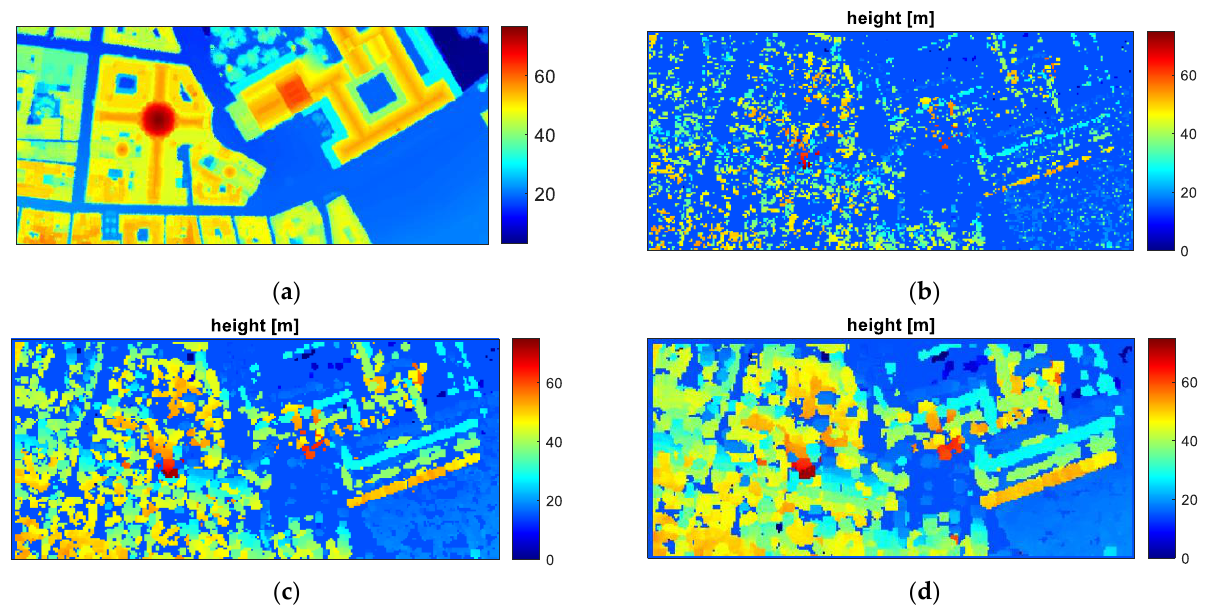
Figure 3. Images of Galleria Umberto I, Naples, Italy. ( a ) Optical image and ( b ) SAR image (Copy- right DLR 2012 – 2014).